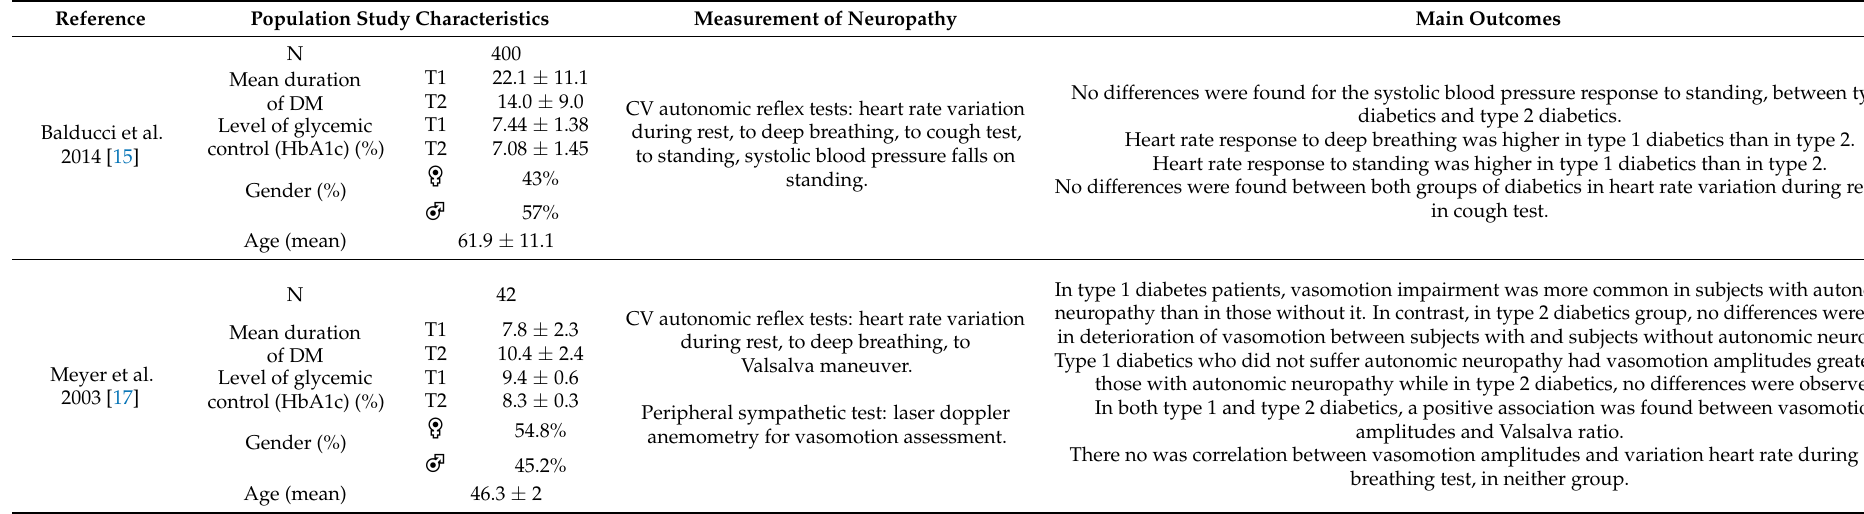
Table 1. Differences between type 1 (T1) and type 2 (T2) diabetes in sensory neuropathy. Table 3. Differences between type 1 (T1) and type 2 (T2) diabetes in autonomic neuropathy. Figure 1. Systematic review workflow.